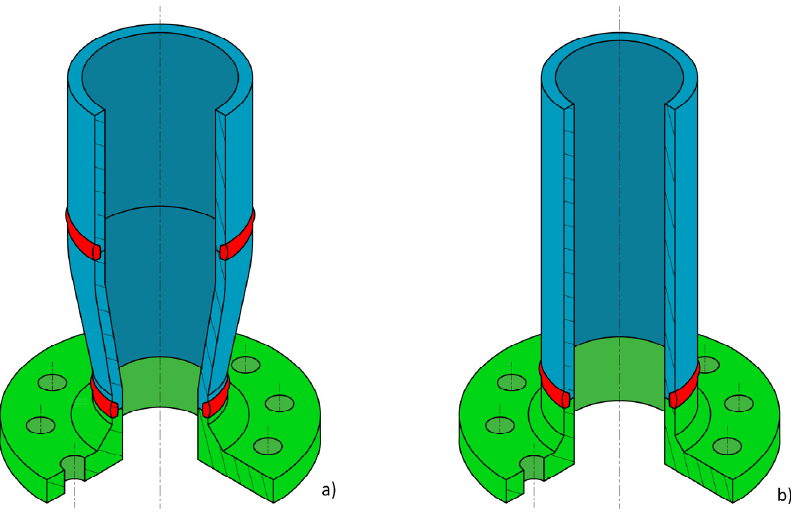
Figure 1. Drawings of the two types of welded joints under investigation. In Figure ( a , b ), the welded zones are in red. The thickness of the pipes is 5 mm, and the outer diameters are 110 mm ( a ) and 100 mm ( b ). The lengths of the two parts taken from Circuit n.2 are about 500 mm.